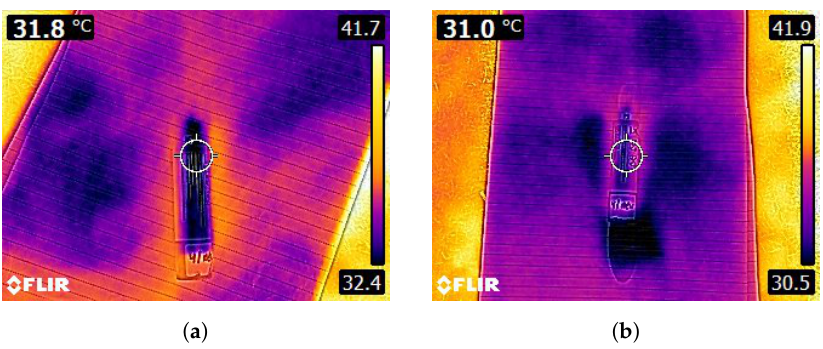
Figure 14. ( a ) Flight test 6—temperature of fuel stick before take-off; ( b ) Flight test 6—temperature of fuel stick after landing. Flight test 6—fuel stick temperature profiles. Images captured by thermal imaging device